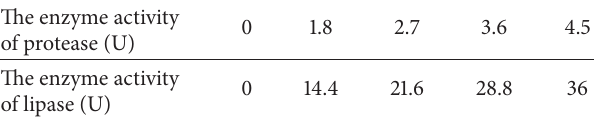
Table 1: The combination of two enzyme activities.